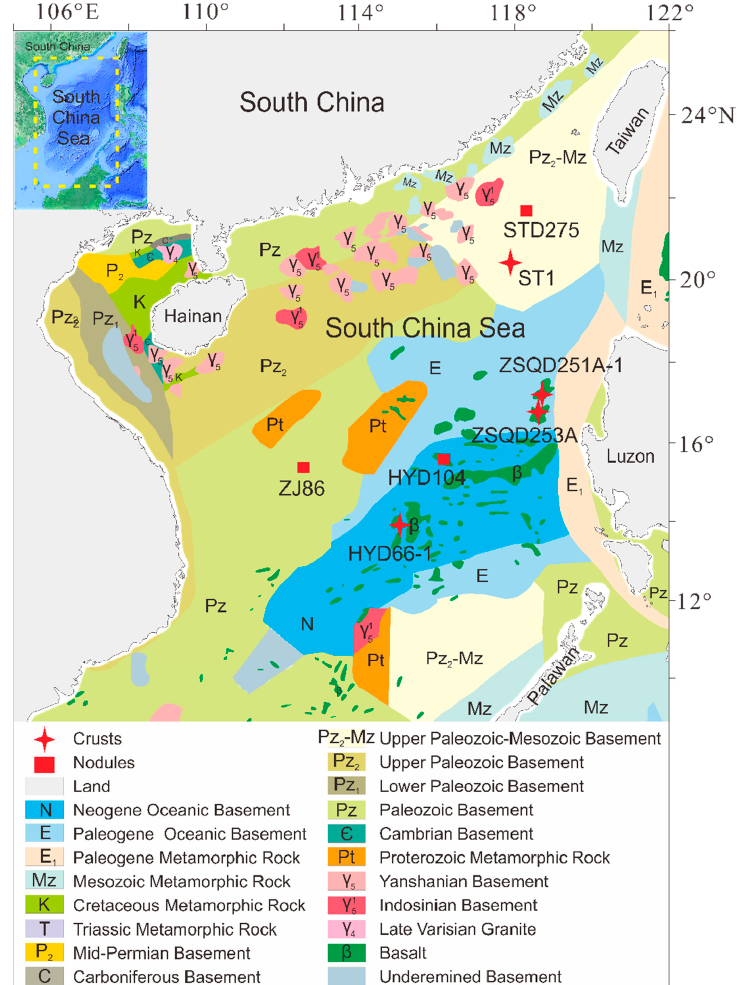
Figure 1. Map of the South China Sea basement and the sample locations (revised after Yang et al. [60]). Yellow dash-square on the top-left inset shows the location of the South China Sea.